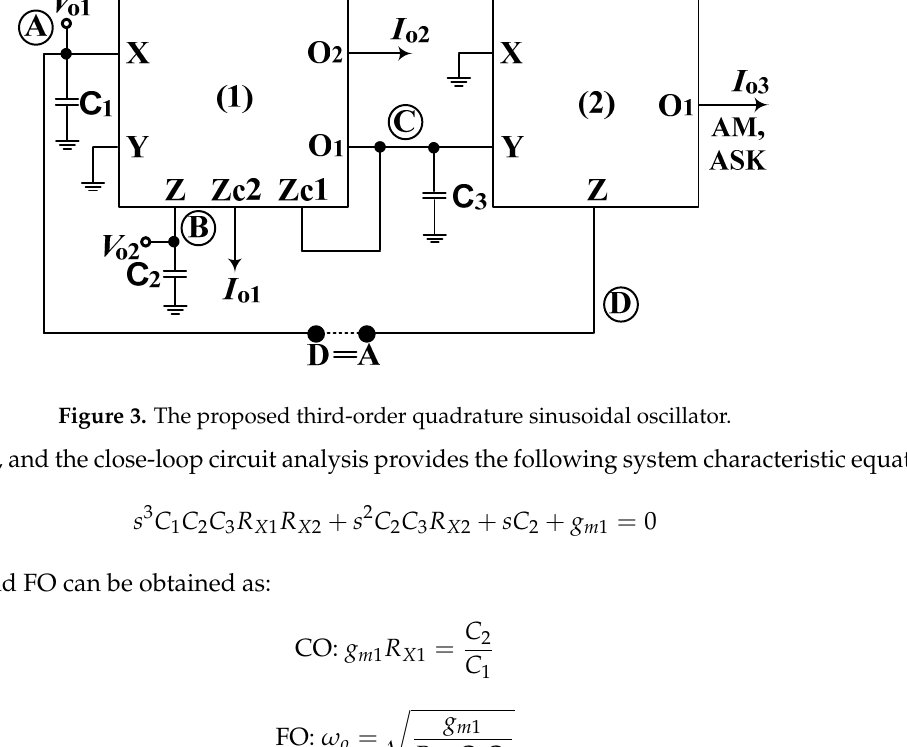
Figure 2. MO-CCCCTA symbol.